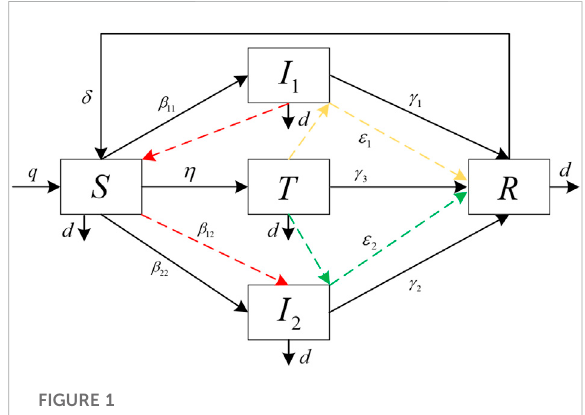
FIGURE 1 The information dissemination process of L-SITR